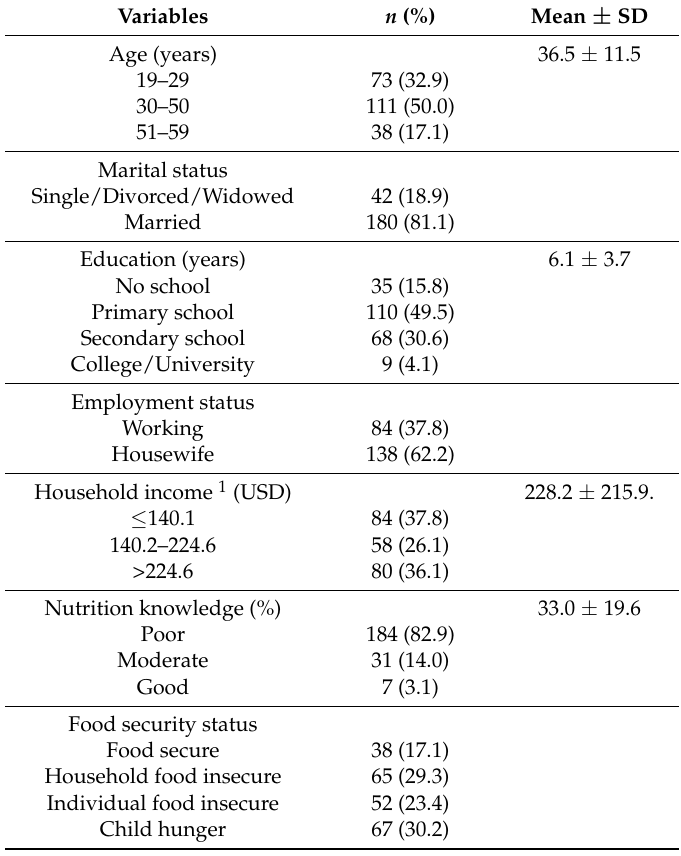
Table 3. Socioeconomic characteristics, nutrition knowledge, and food security status of the respondents ( n =